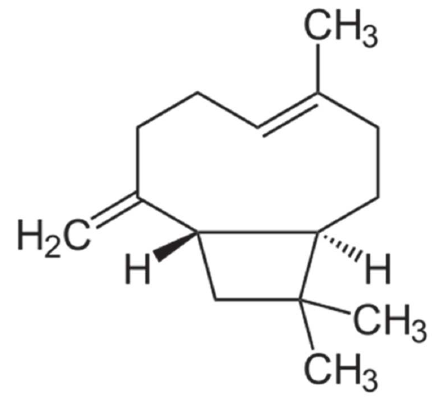
Table 5. Binding energy values for each conformation generated by the blind molecular docking for the A740003 (known antagonist). In addition, a reference in this work, the A740003 allosteric site is named site 1, and the ATP binding site is named site 2. A few confirmations were docked in random non-pocket positions in the P2X7R, which were not considered a potential binding site. Conformation Energy kcal/mol Binding